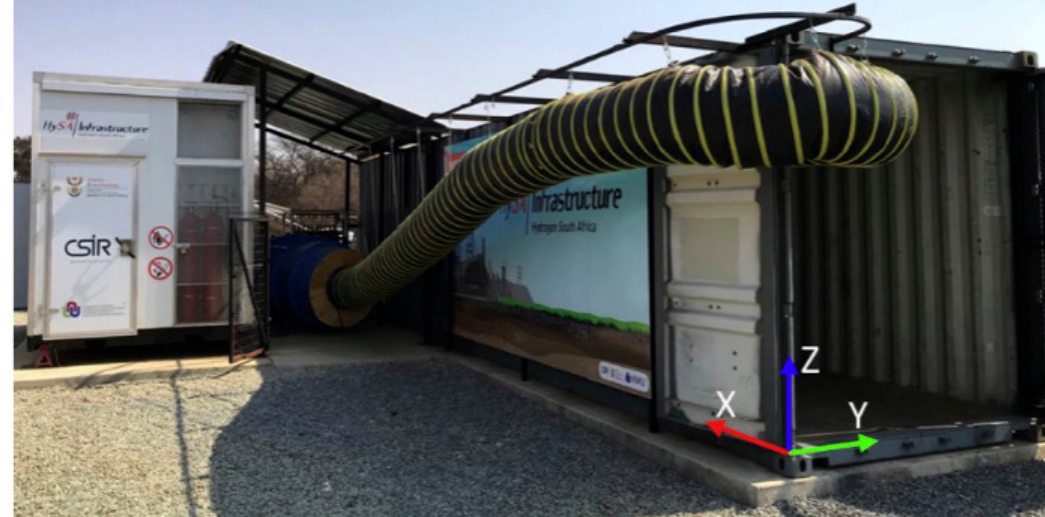
Figure 20. HySA mining platform test facility for green mining (reproduced from [188] with permission from Elsevier).